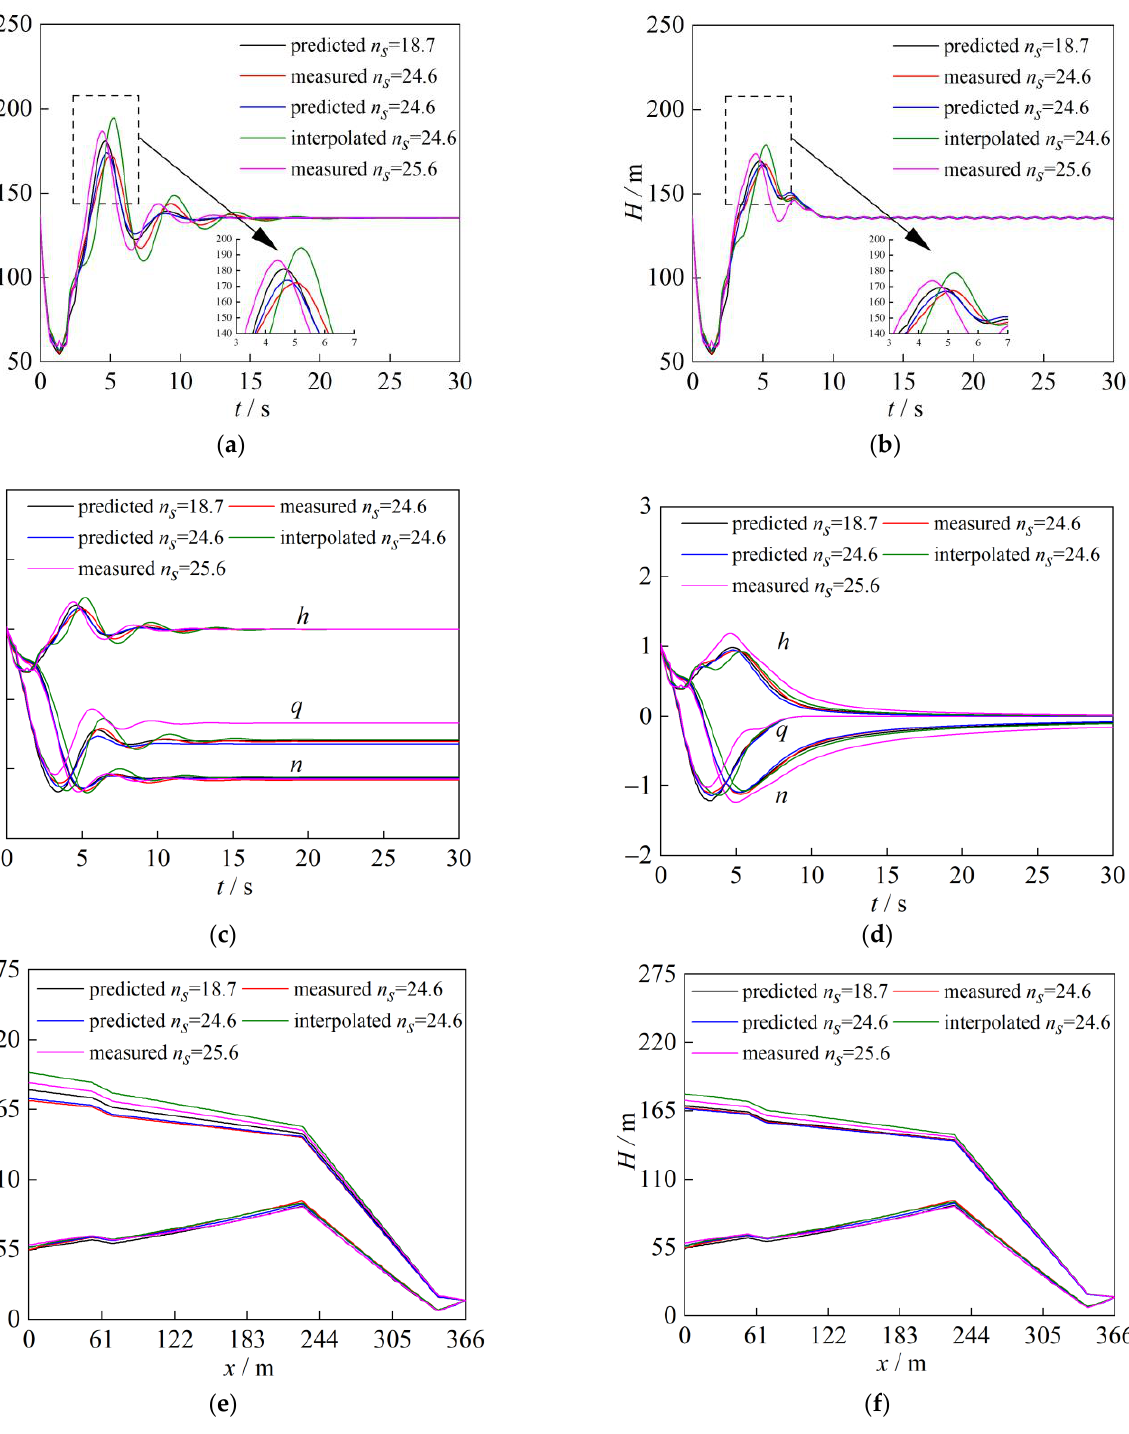
Figure 13. Simulation results of hydraulic transients under valve rejection and valve two-stage closing conditions: ( a ) variation process of control valve outlet pressure under condition one; ( b ) variation process of control valve outlet pressure under condition two; ( c ) variation process of relative speed, discharge and head of the pump under condition one; ( d ) variation process of relative speed, discharge and head of the pump under condition two; ( e ) maximum and minimum pressure envelopes along the pipeline under condition one; ( f ) maximum and minimum pressure envelopes along the pipeline under condition two. Table 3. Extreme values under valve rejection and valve two-stage closing conditions.